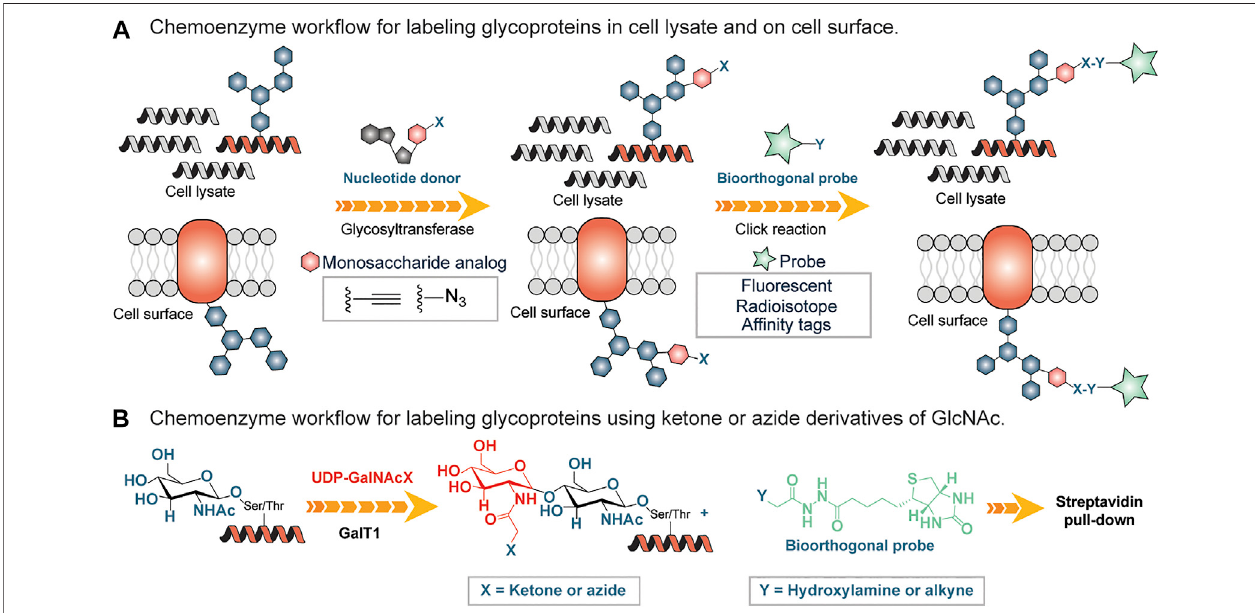
FIGURE5|(A) Chemoenzymaticglycanlabelingoncelllysatesusingamonosaccharideequippedwithareactivegroup(X)andtransferredfromanucleotidesugar donor to a glycoprotein in the cell lysates or cell surfaces by a Glycosyltransferase. Y is derivatized with an af fi nity tag or fl uorescent probe and subsequently enriches labeled glycoproteins. (B) Chemo-enzymatic labeling work fl ow using a mutated galactosyltranferase GalT1 to insert GlcNAc bearing ketone or azide handles, followed by enrichment using hydroxylamine or alkyne derivatized biotin tag.